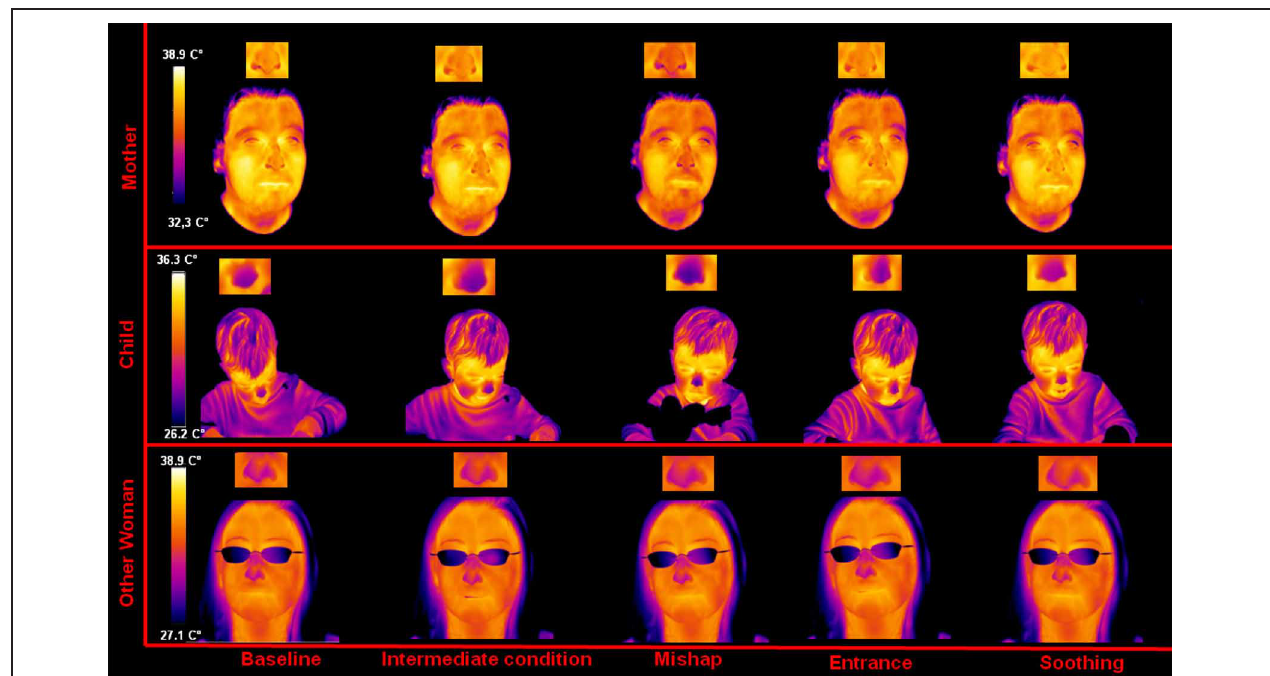
FIGURE 1 | Facial thermal imprints of one of the mother-other woman-child triads.